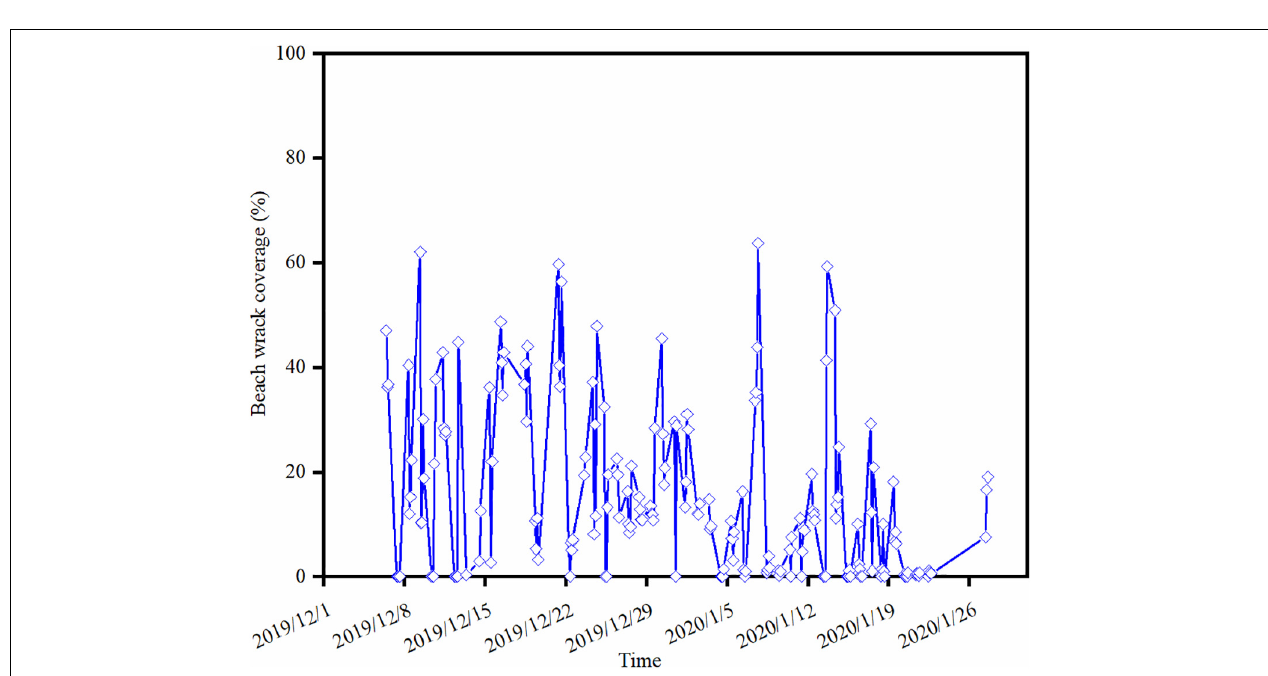
FIGURE 4 | Wrack dynamics on the study beach during the camera trap monitoring period, achieved by the VGG network identification from the image dataset.